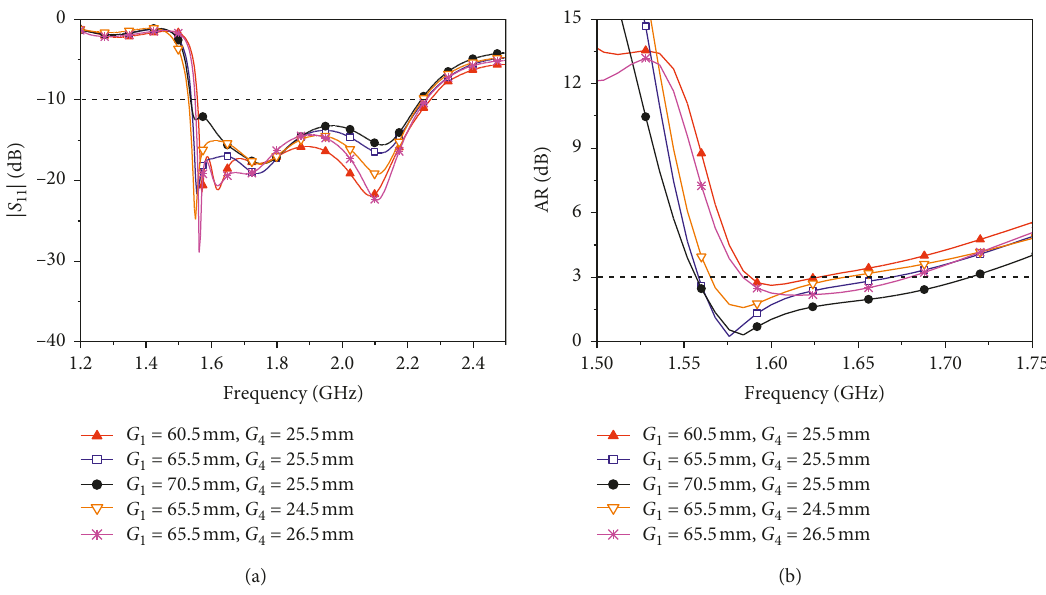
Figure 9: Variations of (a) | S 11 | and (b) AR with different dimensions of the outer ring of the reflector, G 1 and G 4 .